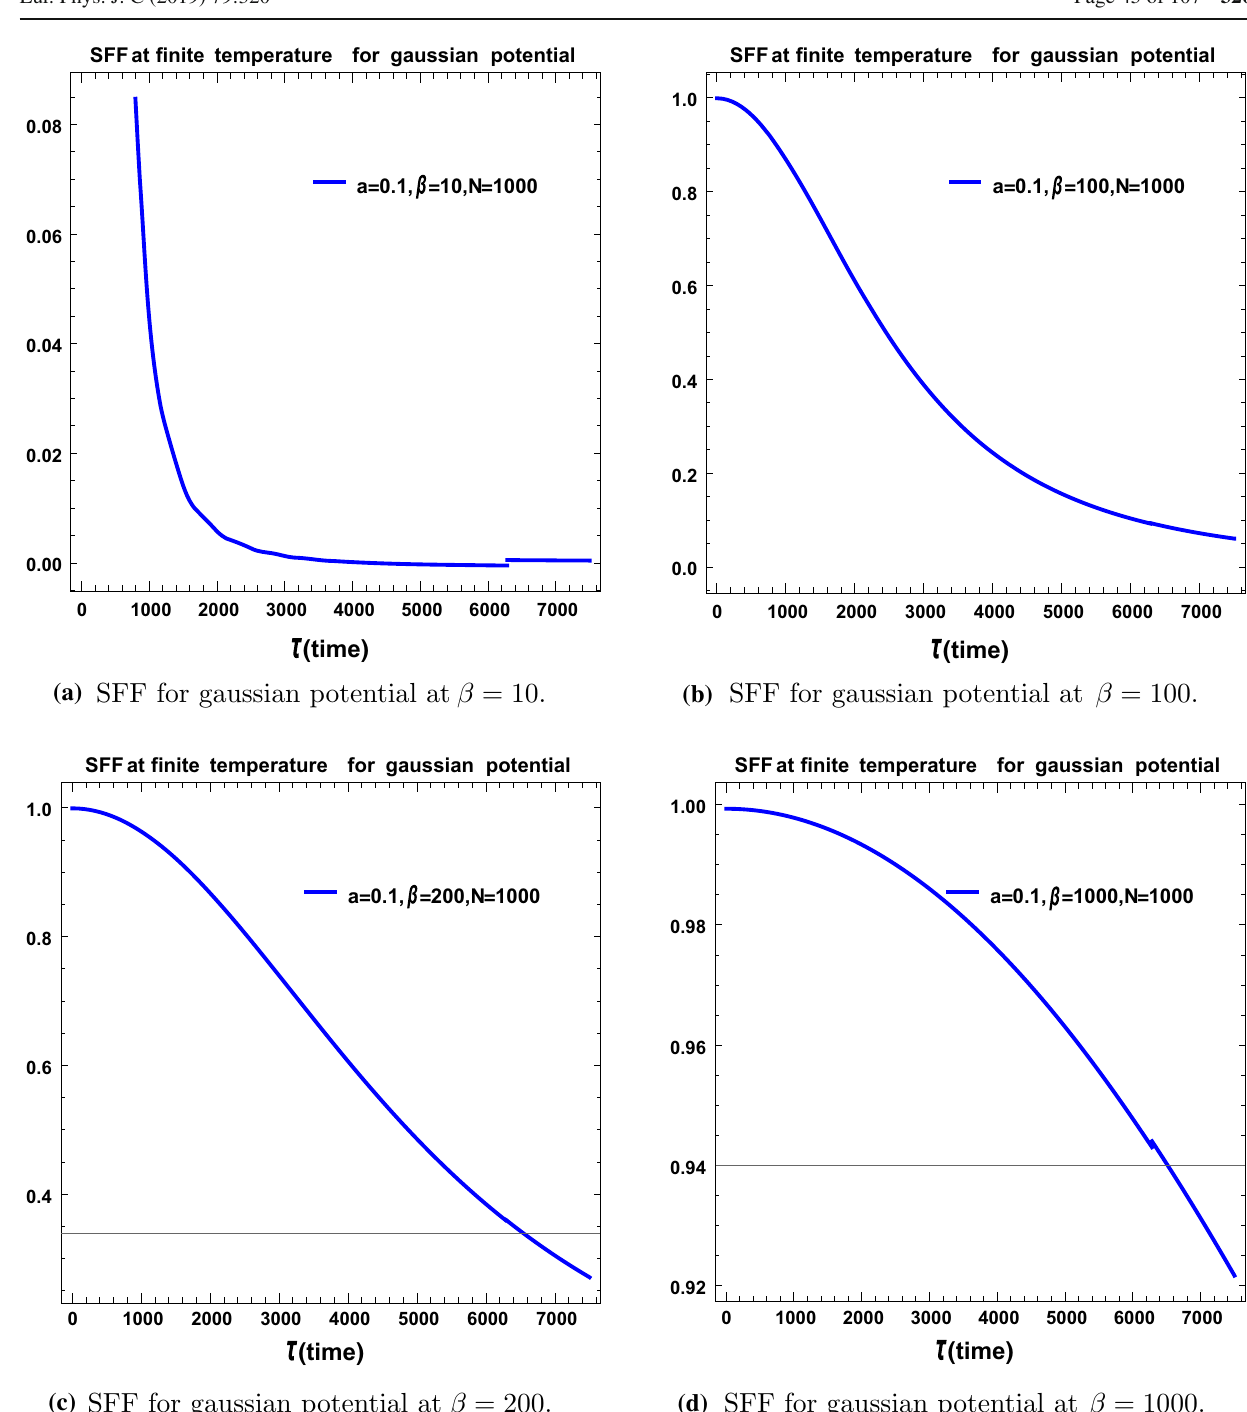
Fig. 23 Spectral Form Factor for Gaussian potential at different finite temperature[ β ] with N = 1000 and a = 0 .